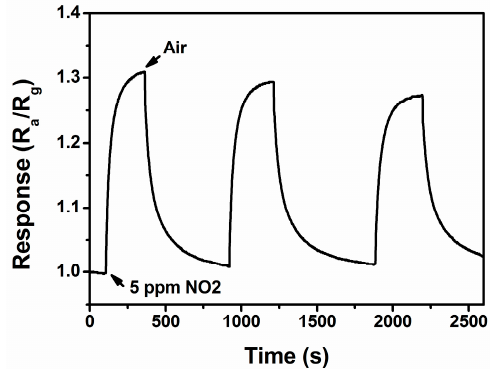
Figure 9. The reproducibility of the rGO/Au sensor on successive exposure (3 cycles) to 5 ppm NO 2 at 50 °C.